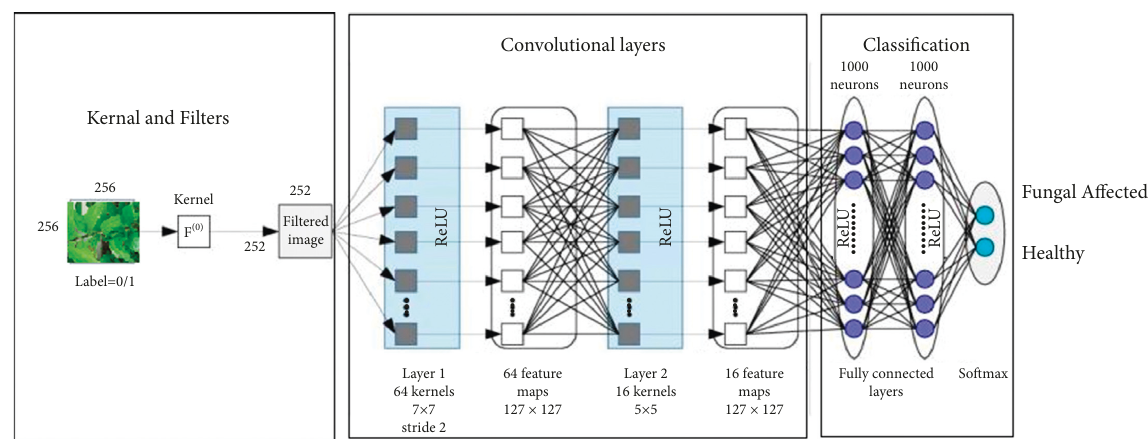
Figure 4: Architecture of CNN